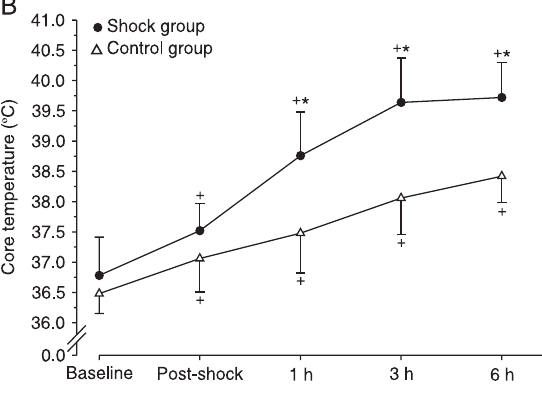
Figure 3. Perfusion and inflammatory features of pigs during the study. Filled circles = shock group; open triangles = control group. Panel A, hemoglobin mixed venous saturation over time (two-way ANOVA: P = 0.023, between analysis; P = 0.002, within analysis and P = 0.701, factor x time interaction). Panel B, core temperature over time (two-way ANOVA: P = 0.023, be- tween analysis; P = 0.002, within analysis and P = 0.701, factor x time interaction). Panel C, serum concentration of interleukin 6 (two-way ANOVA: P < 0.001, between analysis; P < 0.001, within analysis and P = 0.070, factor x time interaction). Data are reported as means ± SD for 5 pigs in each group. *P < 0.05 vs control group (Tukey post hoc analysis). + P < 0.05 vs baseline (Tukey post hoc